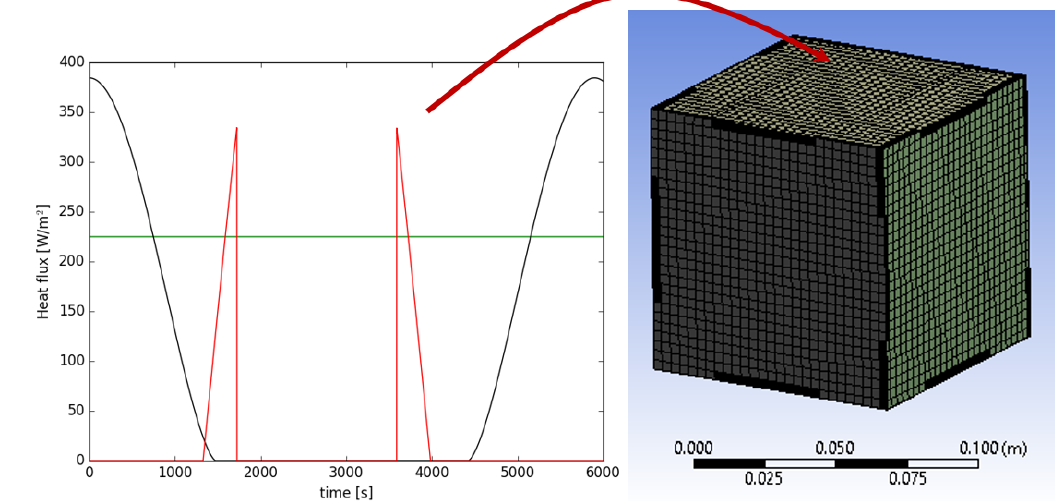
Figure 3. Computational mesh and radiative heat fluxes over panel 2 as function of time, black, red and green curves correspond to the direct solar, albedo and Earth infrared radiative heat fluxes over P2 ( β = 57 ◦